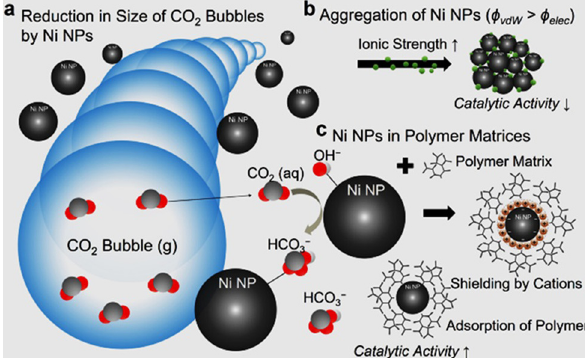
Figure 12: Typical catalytic activity of NiNPs [ 131 ] . ( a ) reduction of CO 2 bubbles, ( b ) aggregation of NiNPs and ( c ) adsorption of polymers.